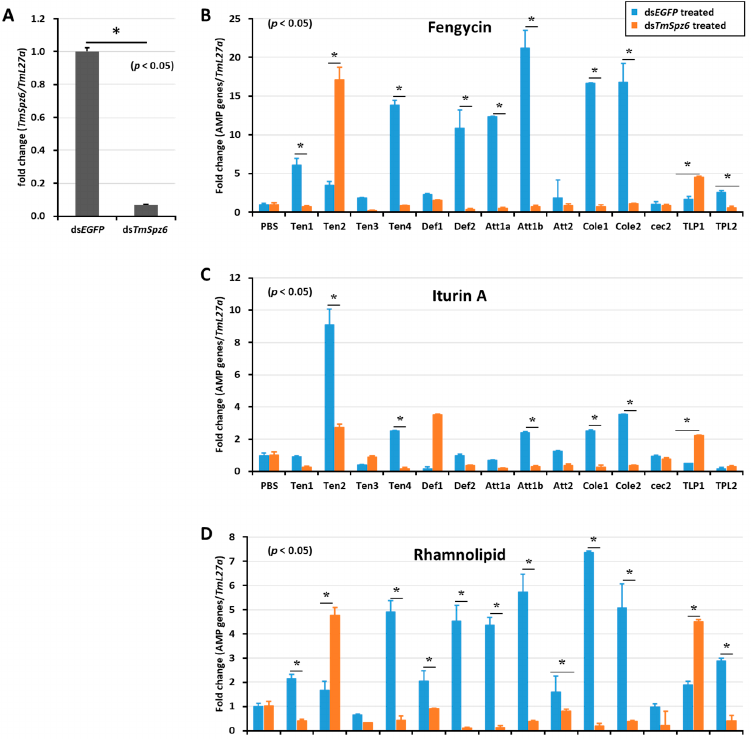
Figure 7. E ff ect of TmSpz 6 gene silencing on AMP induction in T. molitor larvae. TmSpz 6 expression was silenced ( A ), then either fengycin ( B ), iturin A ( C ), or rhamnolipid ( D ) was injected into the gene-silenced larvae. Whole-body AMP expression was examined after 9 h post biosurfactant injection. The expression of AMPs in each tissue was quantified by qRT-PCR, using specific primers. The data are the mean of three individual replicates. * significant di ff erence ( p < 0.05) in AMP expression, compared to the ds EGFP -injected